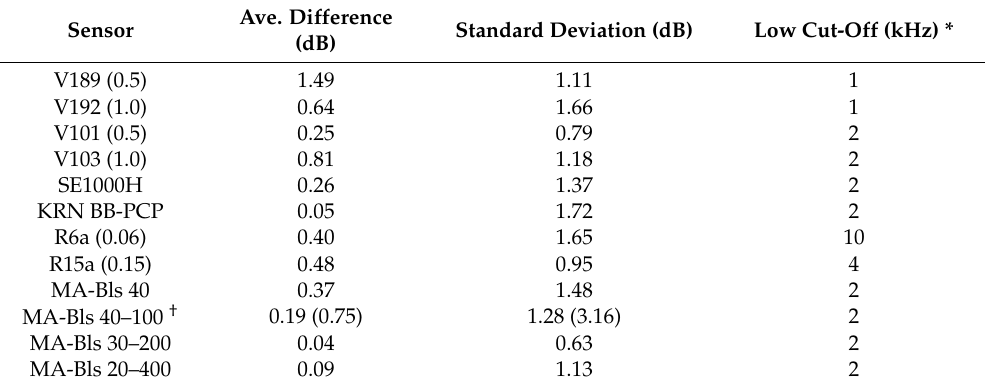
Table 2. Average spectral differences between two calibration